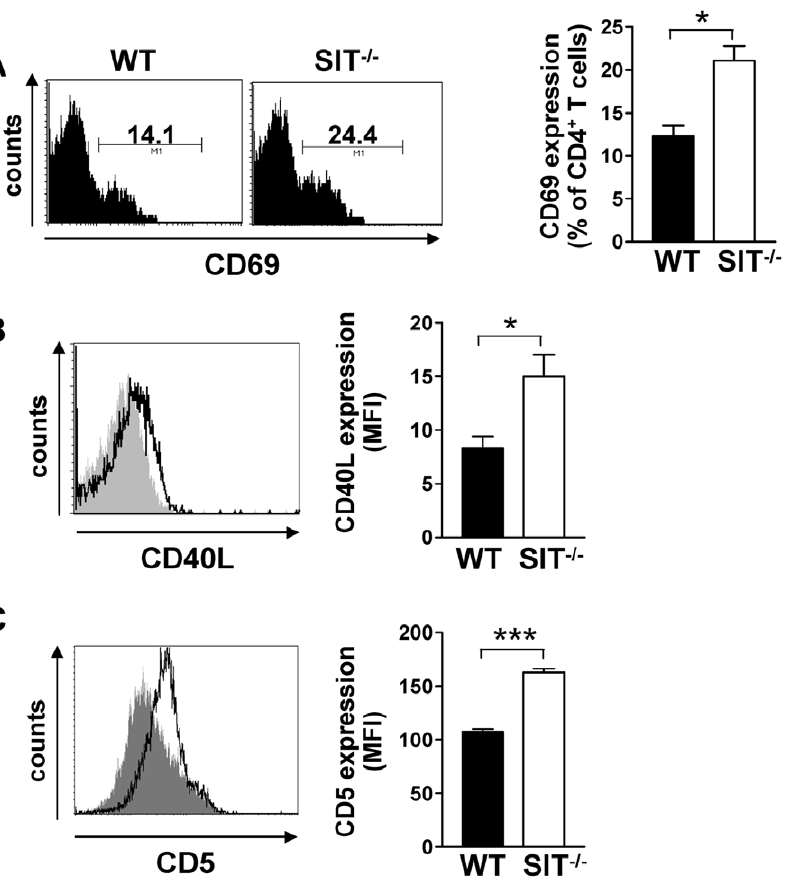
Figure 4. Analysis of activation markers in SIT 2 / 2 mice. A) Splenic CD4 + T cells from 1 year-old SIT-deficient and wild-type mice were analyzed for CD69 expression. Numbers within histograms indicate the percentage of cells. One representative profile per group is shown. B) Comparison of CD40L expression on CD4 + T cells isolated from SIT-deficient (empty histogram) and wild-type (filled histogram) mice. Mean fluorescent intensity (MFI) from one representative mouse per group is indicated. C) Comparison of CD5 expression on CD4 + T cells isolated from SIT-deficient (empty histogram) and wild-type (filled histogram) mice. Bar graphs in A), B), and C) represent statistical analyses of CD69, CD40L, and CD5 expression, respectively. Data derive from at least 5 mice per group. Statistical significance * p , 0.05 and ***p , 0.0001.